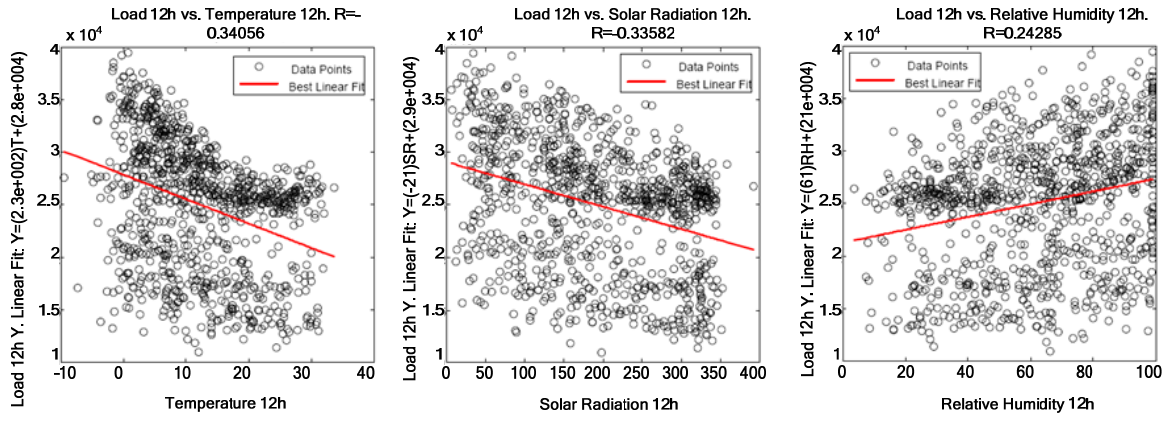
Figure 9. Correlation among temperature global solar radiation, relative humidity and electric power consumption at 12